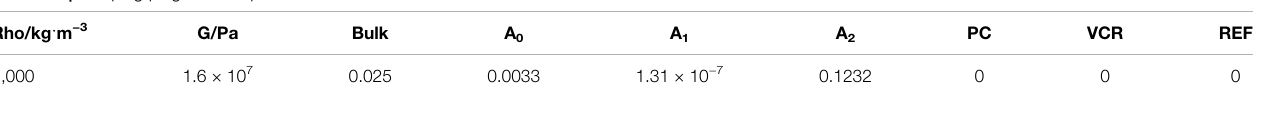
TABLE 3 | Tamping plug material parameters.